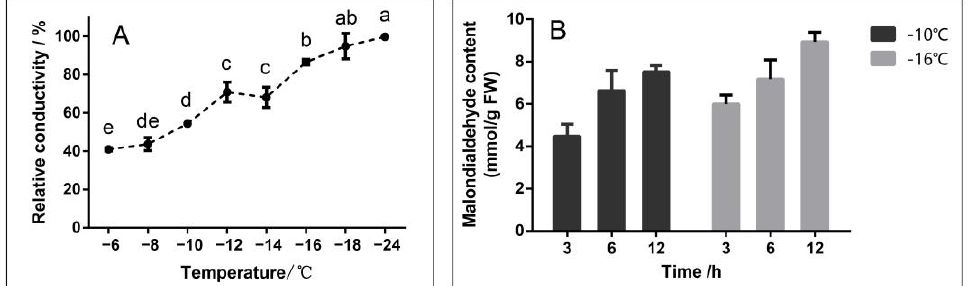
Figure 1. Relative conductivity ( A ) and malondialdehyde content ( B ). ( A ): Relative conductivity of branches after 12 h treatment at different temperatures; means with the same lowercase letter are not significantly different among the different temperatures according to Tukey’s test ( p ≤ 0.05); ( B ): Malondialdehyde (MDA) content of branches under different stress times at − 10 °C and − 16 °C .